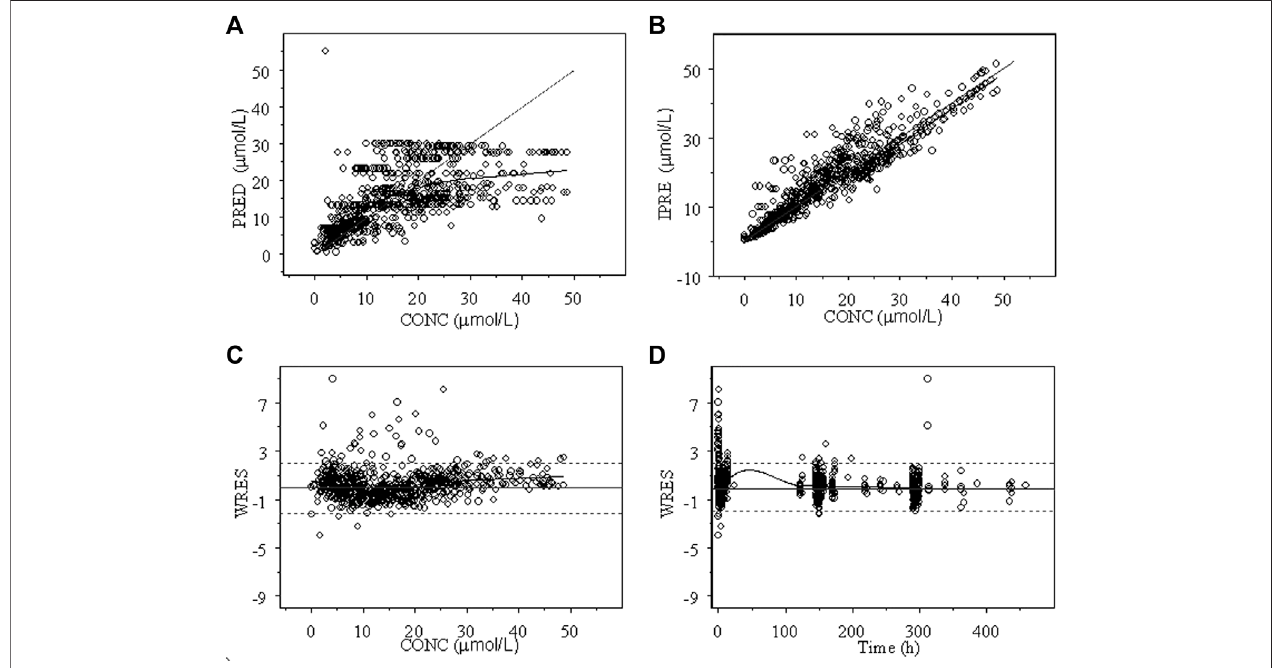
FIGURE 3 | Goodness of fi t of AcINH from the fi nal integrated PPK model in Chinese healthy subjects and tuberculosis patients. (A) Population predicted concentration (PRED) vs. observed concentration (CONC); (B) individual predicted concentration (IPRE) vs. DV; (C) weighted residual error (WRES) vs. CONC; (D) WRES vs. time.